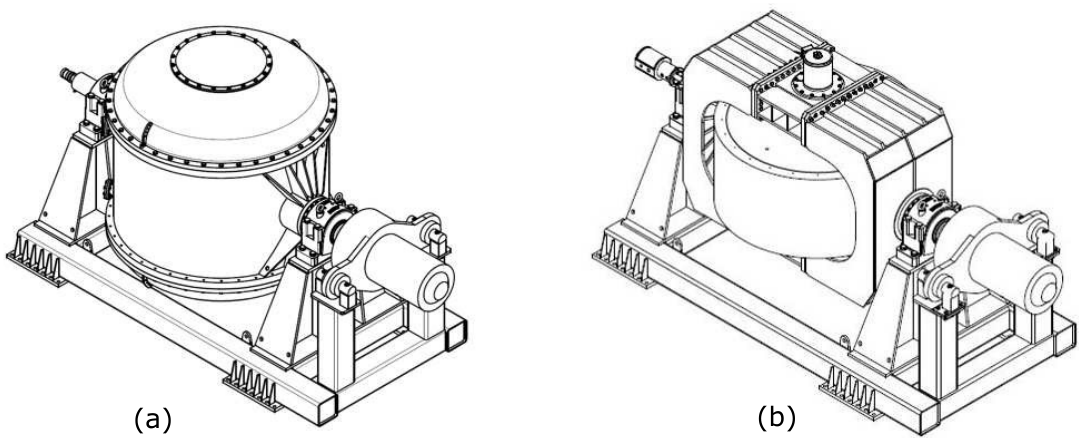
Figure 1. Gyroscope units. ( a ): In housing configuration. ( b ): Free